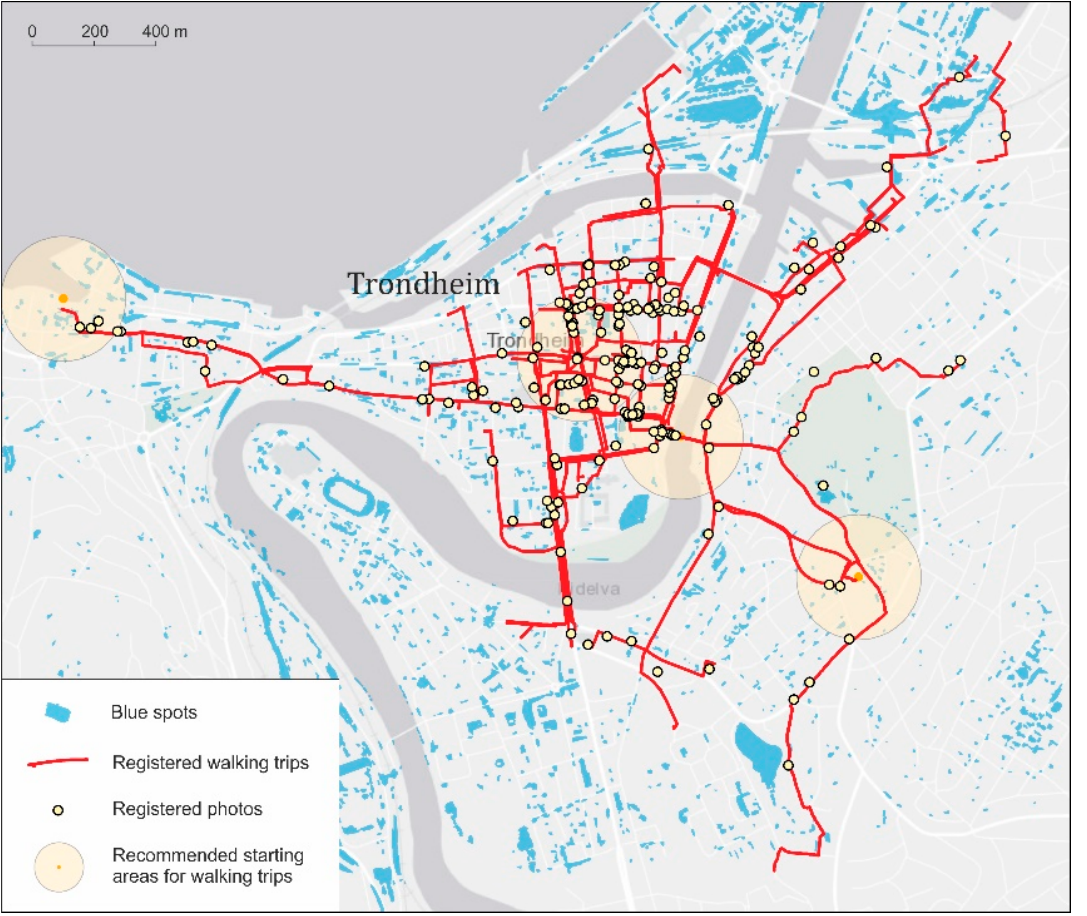
Figure 4. The 133 walking trips registered by the selected 56 participants.